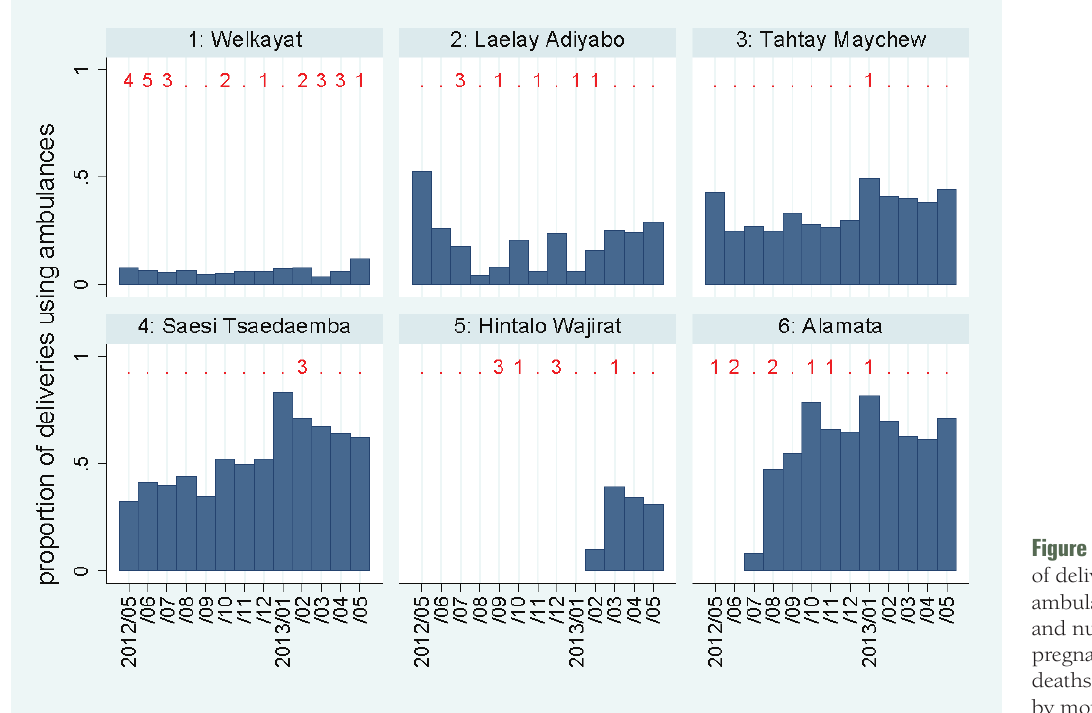
Figure 2. Proportions of deliveries using ambulance transport and numbers of deaths (figures in red), by month and